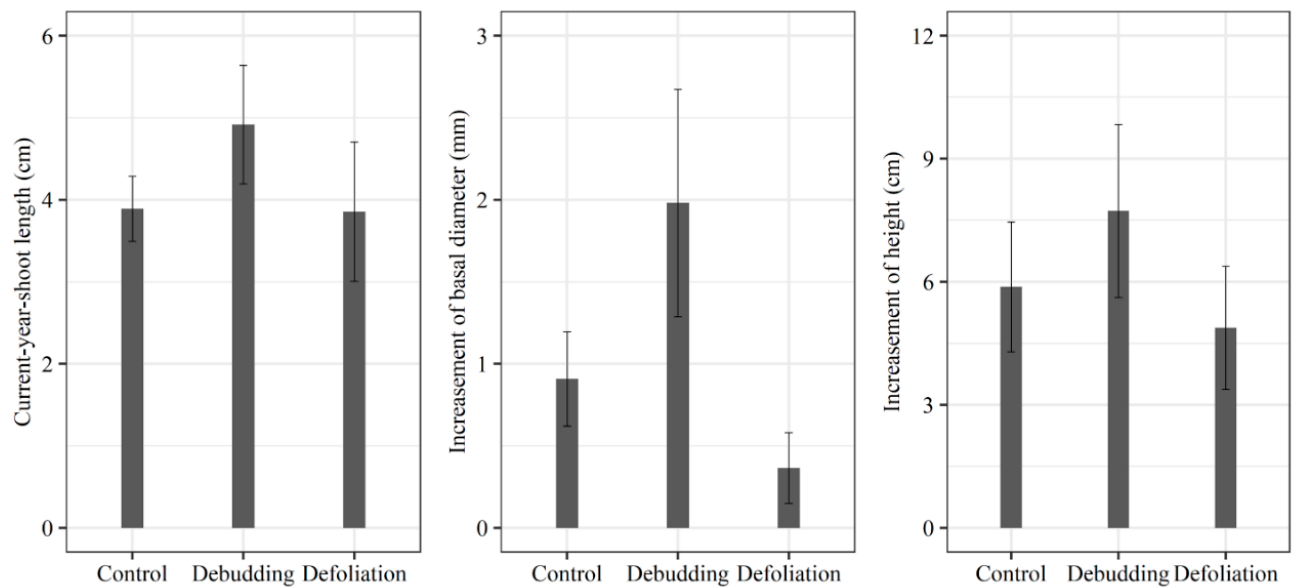
Figure 4. Growth responses of seedlings to control, defoliation, and debudding treatments in one year. The results are shown as the mean ± standard error. The mean values of each treatment are the average of 5–10 replications (5 replications for defoliation, 8 replications for debudding, and 10 replications for control).